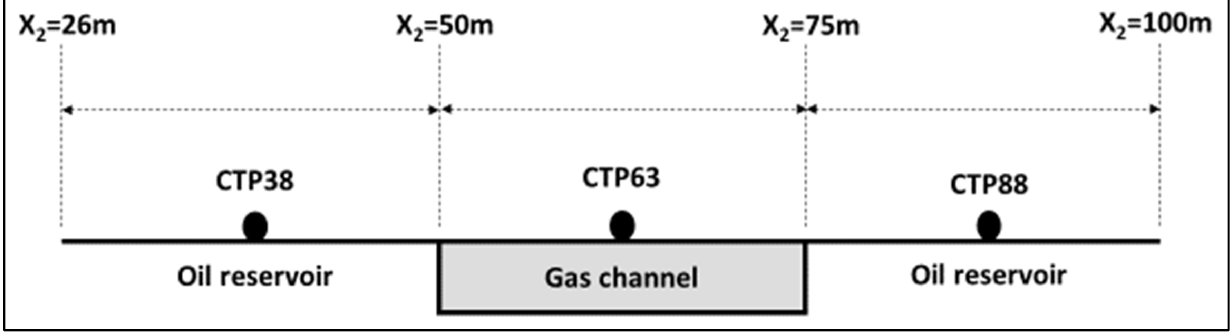
Figure 2. Gas channel model used to test the CTP-TAVO analysis. Table 1. Donati and Martin (1998) reported oil reservoir and gas channel models, respectively.